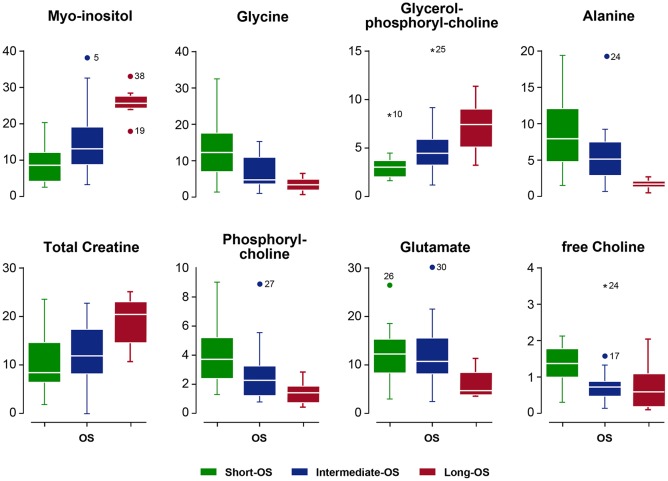
Box-plots of metabolite molar ratios in extracts from glioma biopsies with Short-OS (green), Intermediate-OS (blue) and Long-OS (red). In each box, the central mark (white line) indicates the median, and the bottom and top edges refer to the 25-th and 75-th percentiles, respectively. The upper and lower limits of the box extend to the most extreme data points not considered outliers.